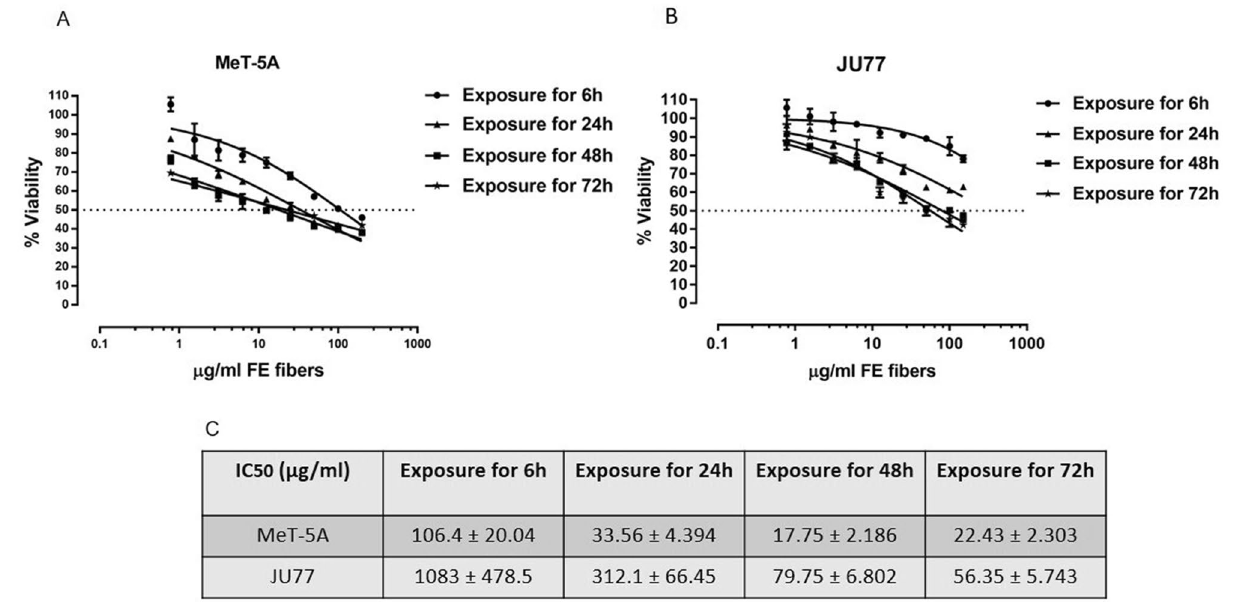
Figure 8. ( A ) Dose–response curves of MeT-5A (human normal mesothelium) with FE fibers from 200 to 0.78 μg/ml until 72 h of treatments; ( B ) Dose–response curves of JU77 (human malignant mesothelioma) with FE fibers from 200 to 0.78 μg/ml from 6 to 72 h of treatments; ( C ) IC50 values (μg/ml) for MeT-5A and JU77 cell lines.